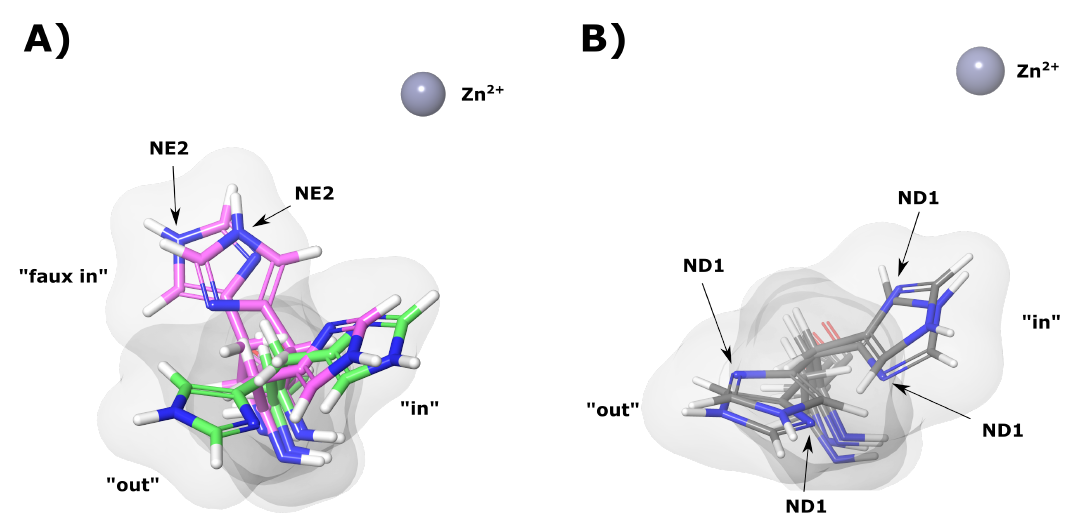
Figure 10. CA-II apo protein His64 “in”, “out” and “faux in” conformations. ( A ) WT and K18E proteins. Green and magenta colors represent WT and K18E, respectively. ( B ) N252D variant. The grey sphere represents the Zn 2 + , white, blue and red structures represent hydrogen, nitrogen and oxygen atoms, respectively. Table 3. Distance of His64 imidazole group from Zn 2 + for the “in” and “out” conformations. All distances are measured from the His64 imidazole ring centroid to the Zn 2 + . Faux refers to other conformations observed excluding traditional “in” and “out” occupied by